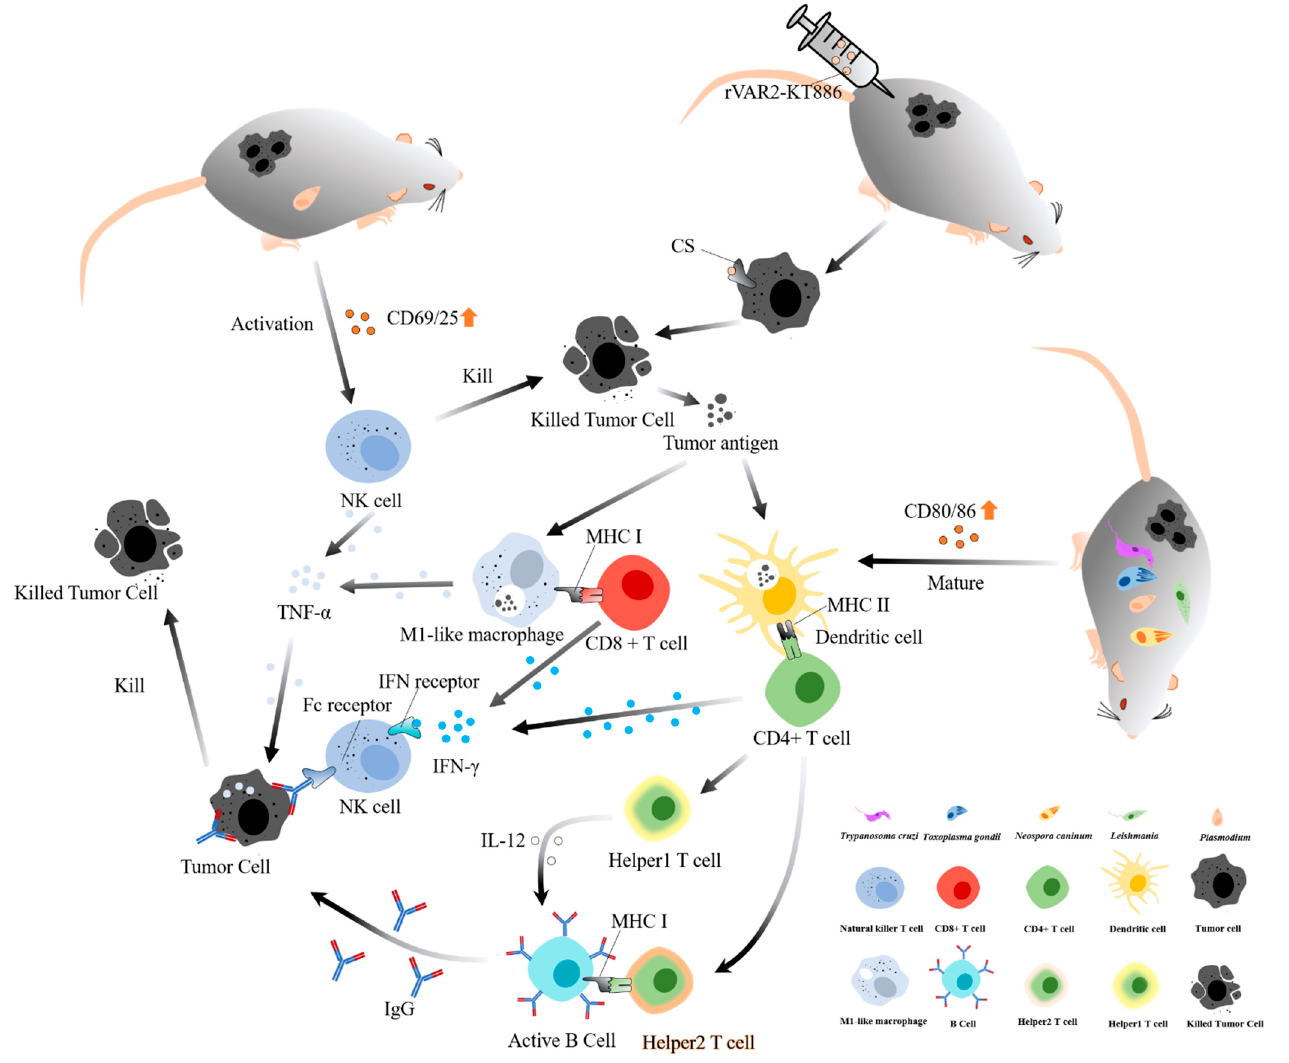
Figure 1. The landscape of the host’s immune system activated by parasites against the tumor. There are three ways that parasites could stimulate the host’s immune system to eliminate tumors. (1) Plasmodium could boost the level of CD69/25 and promote the natural killer T cell activation to secrete TNF- α ; (2) RVAR2-KT886, a targeted drug based Plasmodium rVAR2, could recognize the CS in the surface of tumor cells and then kill it; (3) Toxoplasma gondii , Leishmania , Trypanosoma cruzi , Neospora caninum and Plasmodium could boost the level of CD80/86 and promote the dendritic cell maturity, and the mature dendritic cell actives CD4+ T cell to be Help1 T cell or Help2 T cell through MHC II. Help1 T cell would kill tumor through IL-12/IFN-gamma Axis; Help2 T cell would stimu-